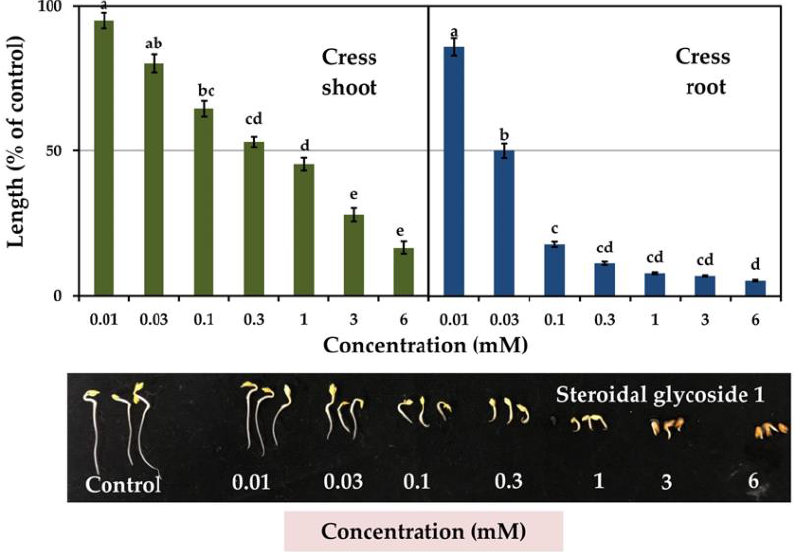
Figure 6. Inhibitory activity of compound 1 on the shoot and root growth of cress. The bars on each